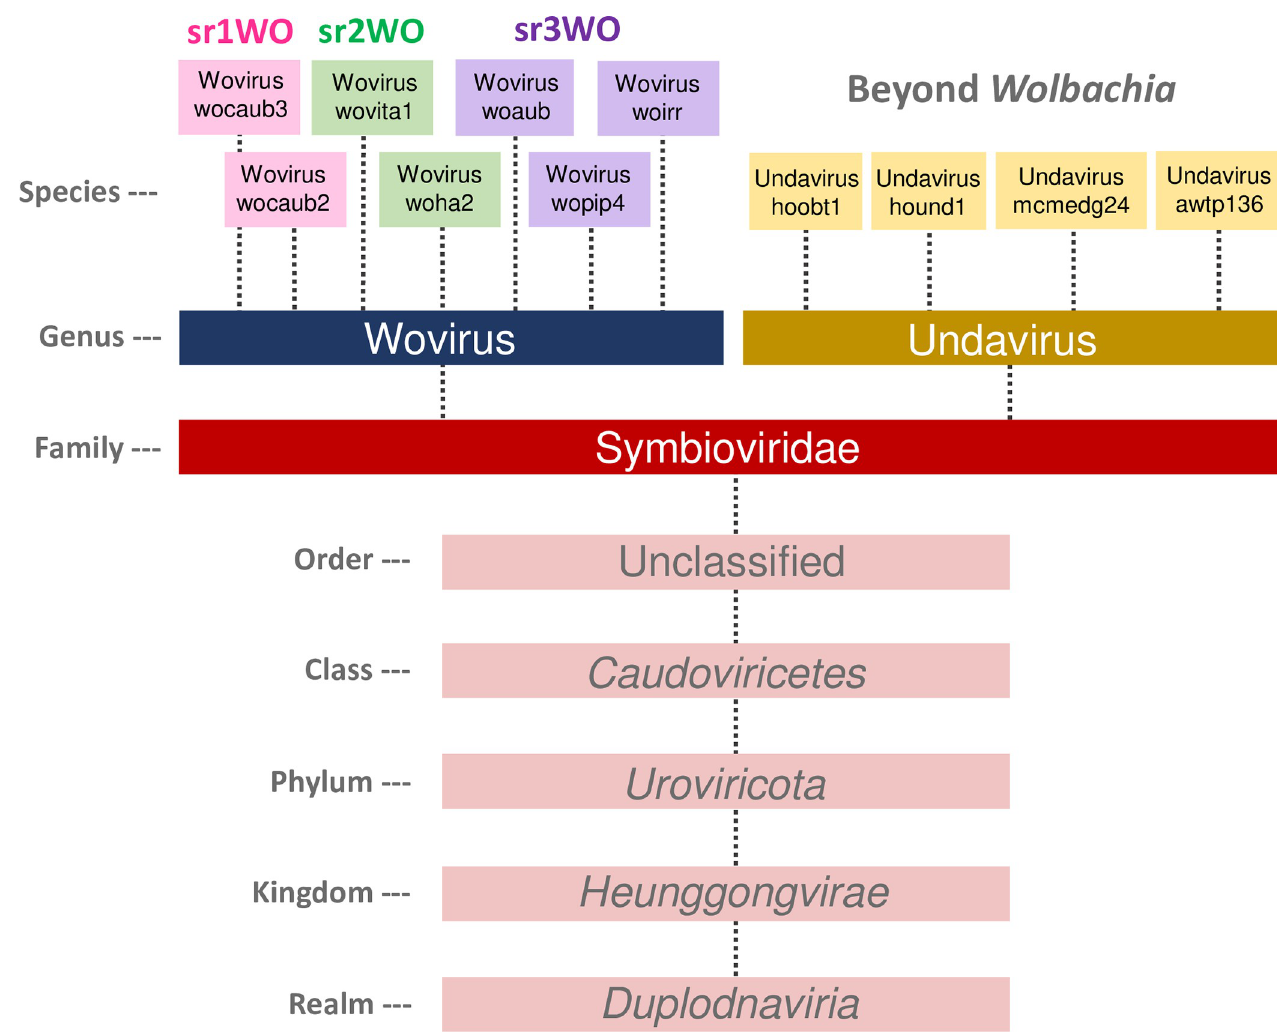
Fig 7. Comparative genomics support a new family-level designation for prophage WO classification. Symbioviridae is proposed as a new taxonomic family of tailed phages within the class Caudoviricetes . It contains viruses that primarily infect Wolbachia (proposed genus Wovirus) and other symbionts including Holospora and metagenome-assembled genomes (MAGs) from aquatic environments (proposed genus Undavirus).